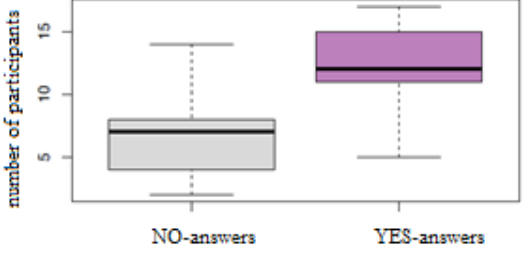
Figure 7 . Boxplot for sentences with